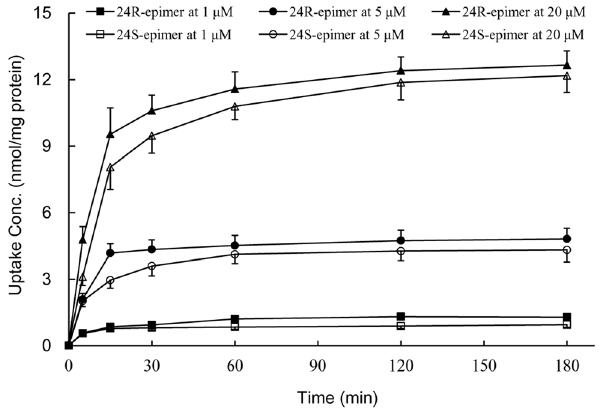
Figure 4. The uptake concentration-time profiles of 24R- epimer and 24S-epimer in Caco-2 cells. 24R-epimer and 24S- epimer concentrations: 1, 5 and 20 m M, respectively. Data are the mean 6 S.E. of three independent experiments.